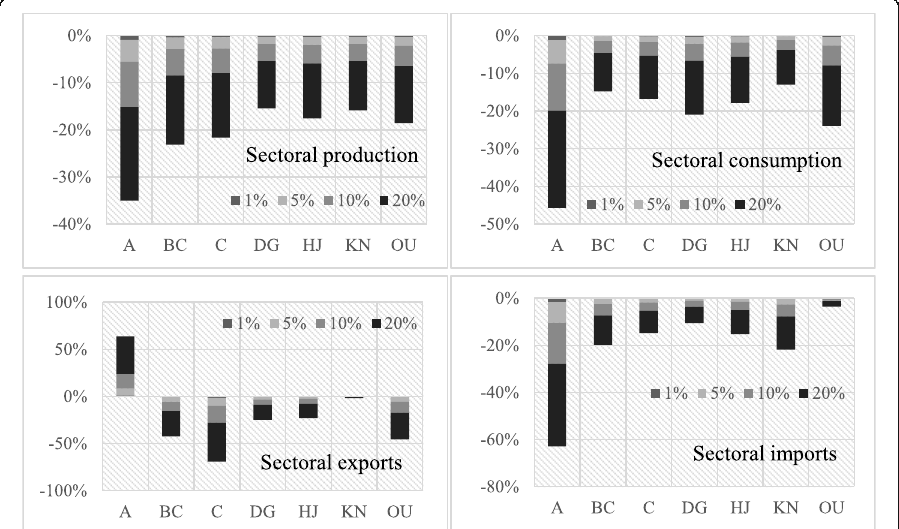
Fig. 8 Simulated sectoral effects of government revenue neutral tax on polluting good (neutralization based on decrease of income tax). (Source: authors calculations based on CGE model simulations